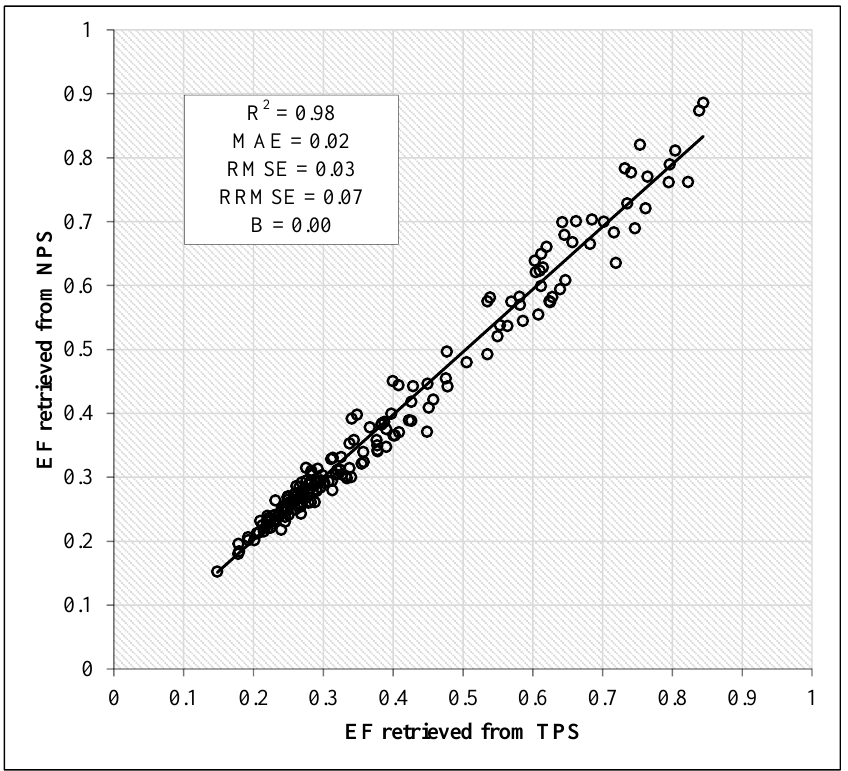
Figure 6. Contrast of EF retrieved from TPS and NPS for all the sites.